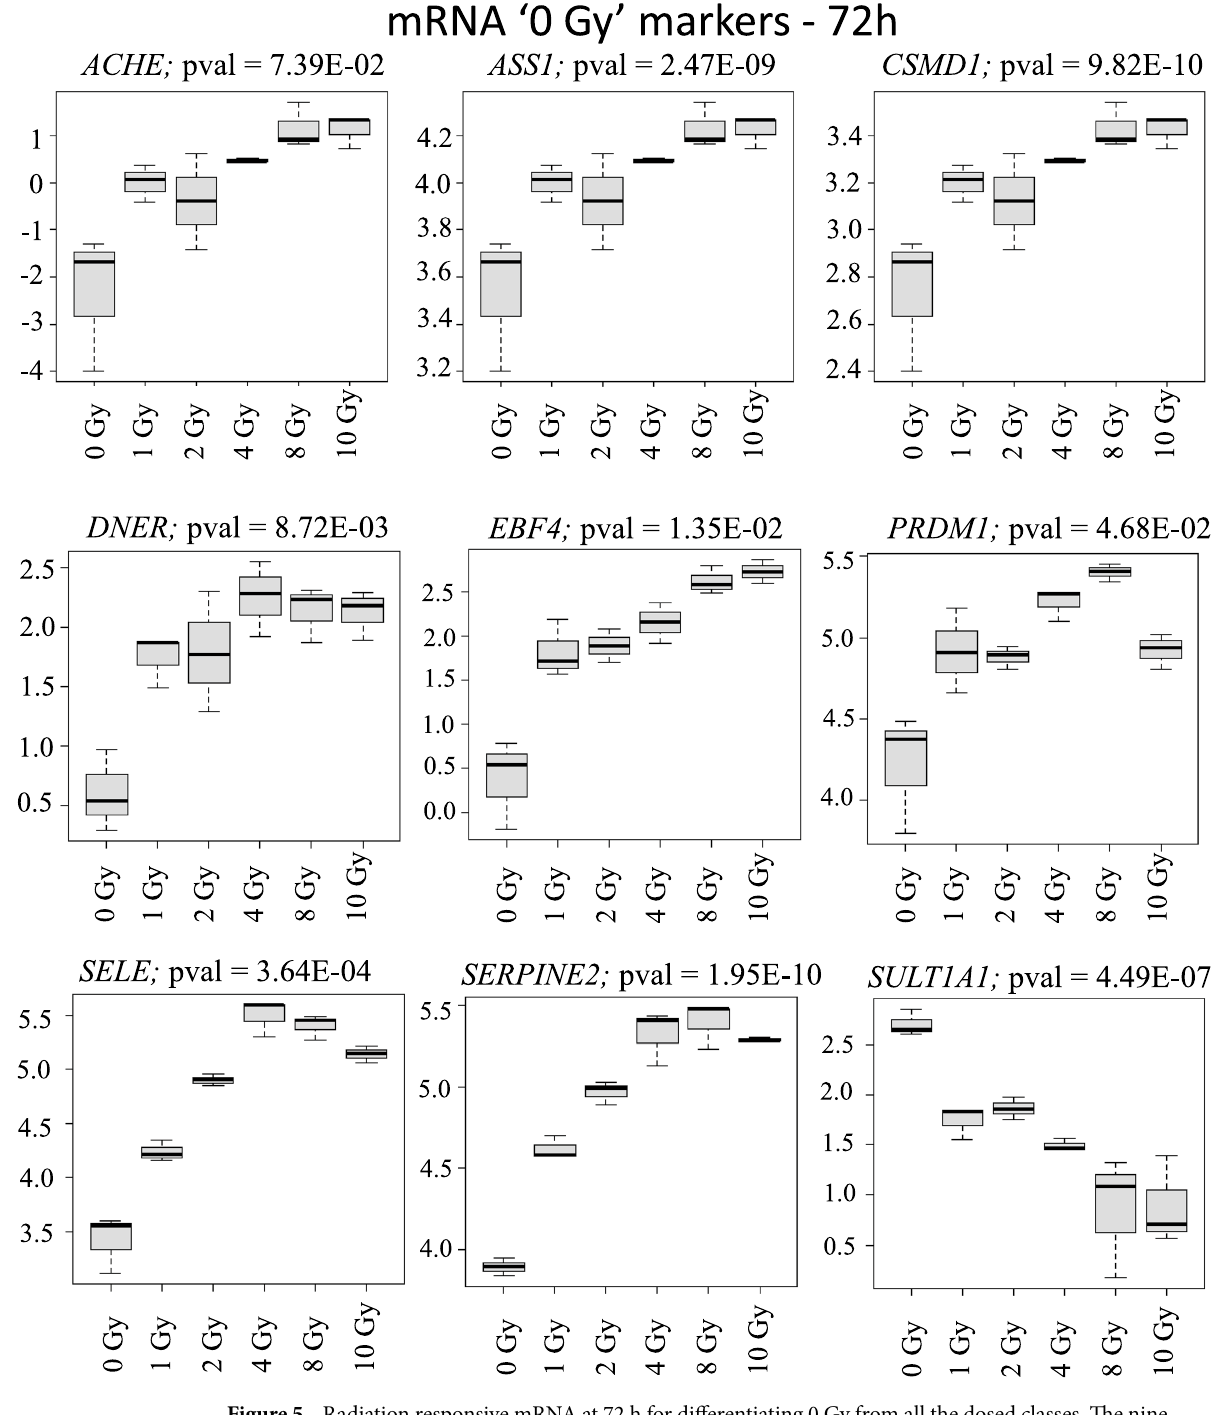
Figure 5. Radiation responsive mRNA at 72 h for differentiating 0 Gy from all the dosed classes. The nine most significant mRNAs out of the nine mRNAs at the intersection of all doses in supplementary Fig. 2B were selected as 0 Gy-72 h markers. Box-plots were generated in R. Y-axis shows the normalized read-counts and X-axis represents dose classes for 72 h